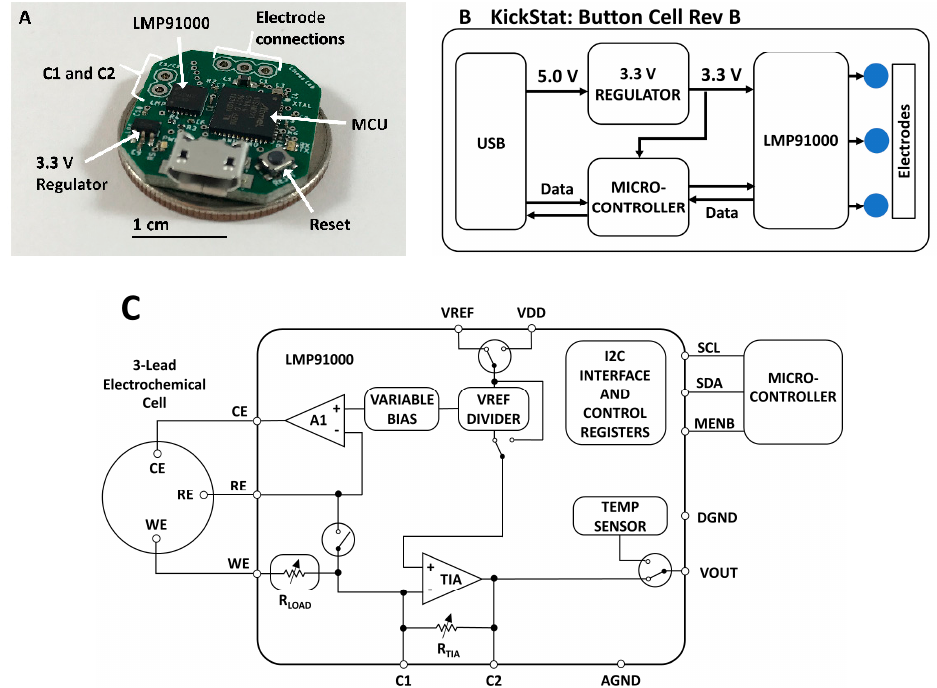
Figure 1. ( a ) Photograph of the assembled KickStat: Button Cell Rev B. The device features the LMP91000 along with a SAMD21 microcontroller running an Arduino bootloader, ( b )